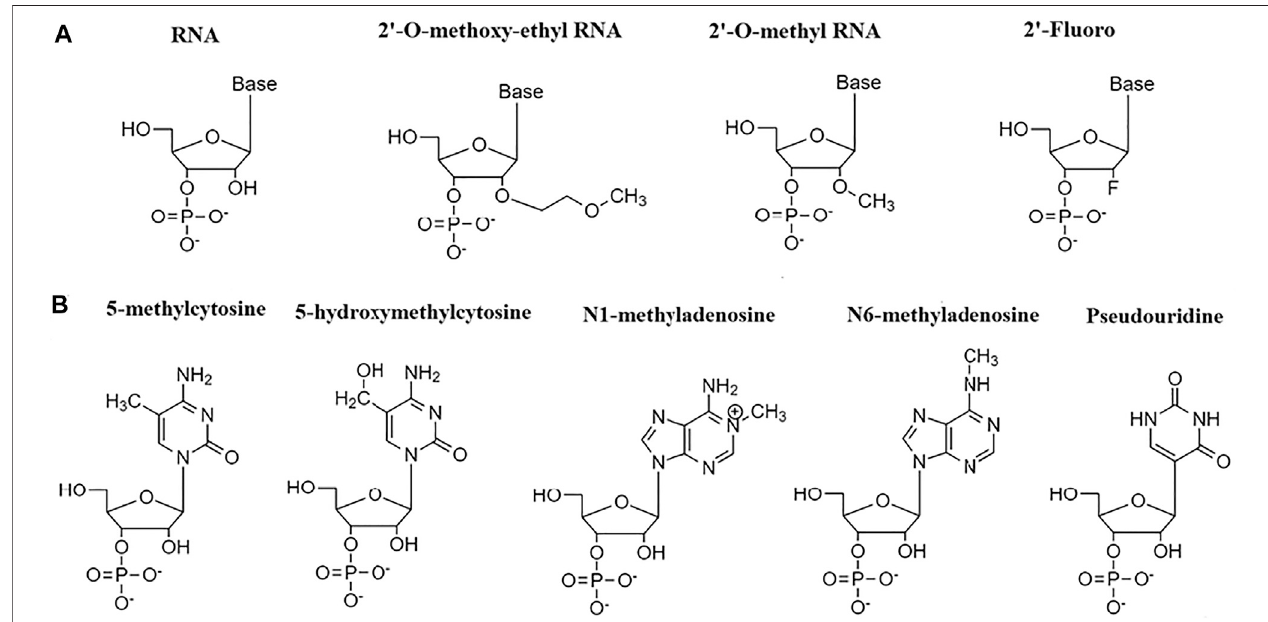
FIGURE 1 | RNA modi fi cations. (A) RNA modi fi cations at 2 ′ position of the ribose sugar ring. (B) RNA modi fi cations at nitrogen bases.